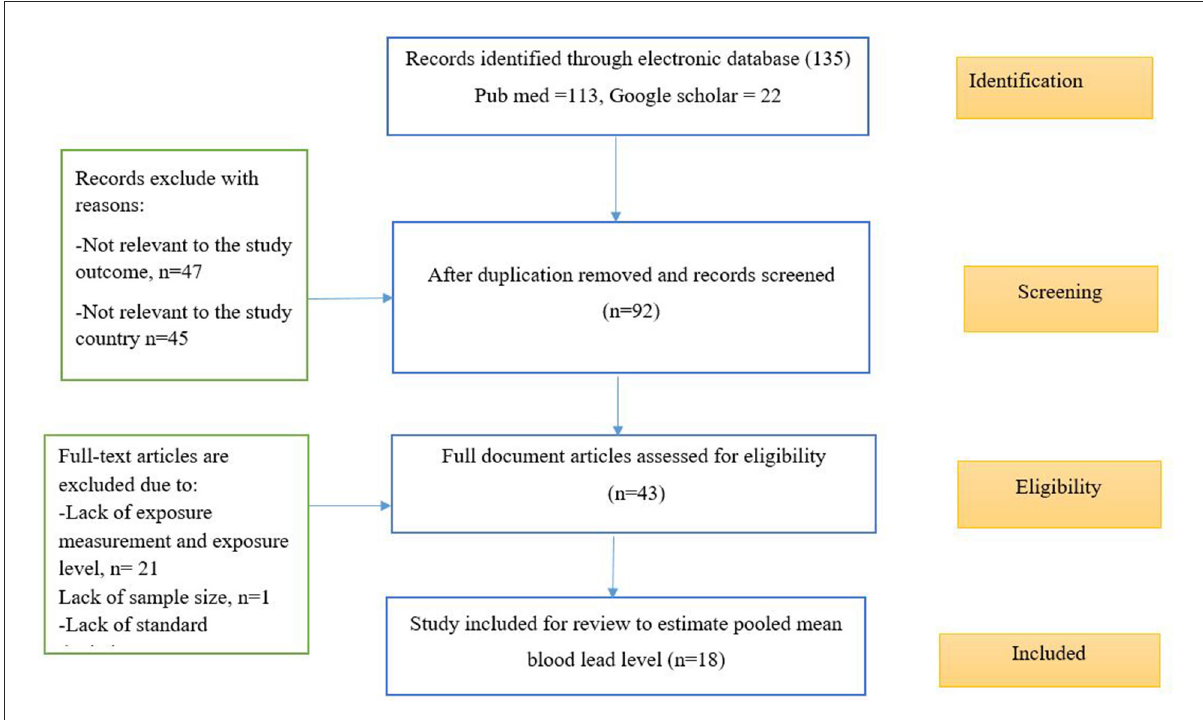
FIGURE1 Article identification, screening, eligibility, and inclusion of studies on BLL among lead battery workers in LMIC, 2022 ( n = 18).